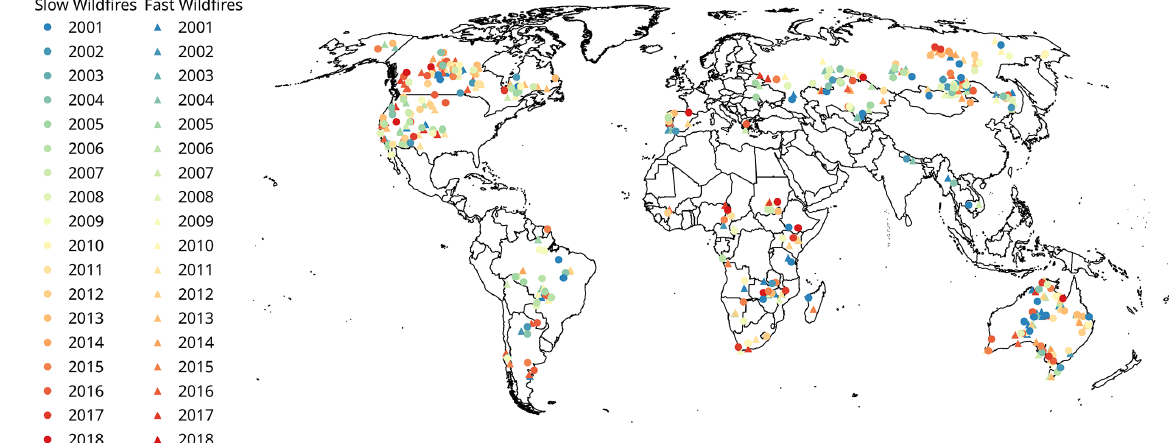
Figure 1. Location of the wildfires coloured by year. Fast fires and slow fires are depicted with triangles and circles